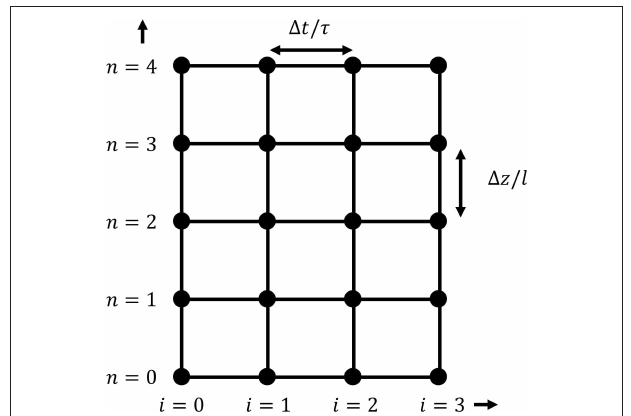
FIGURE 11 | Computational